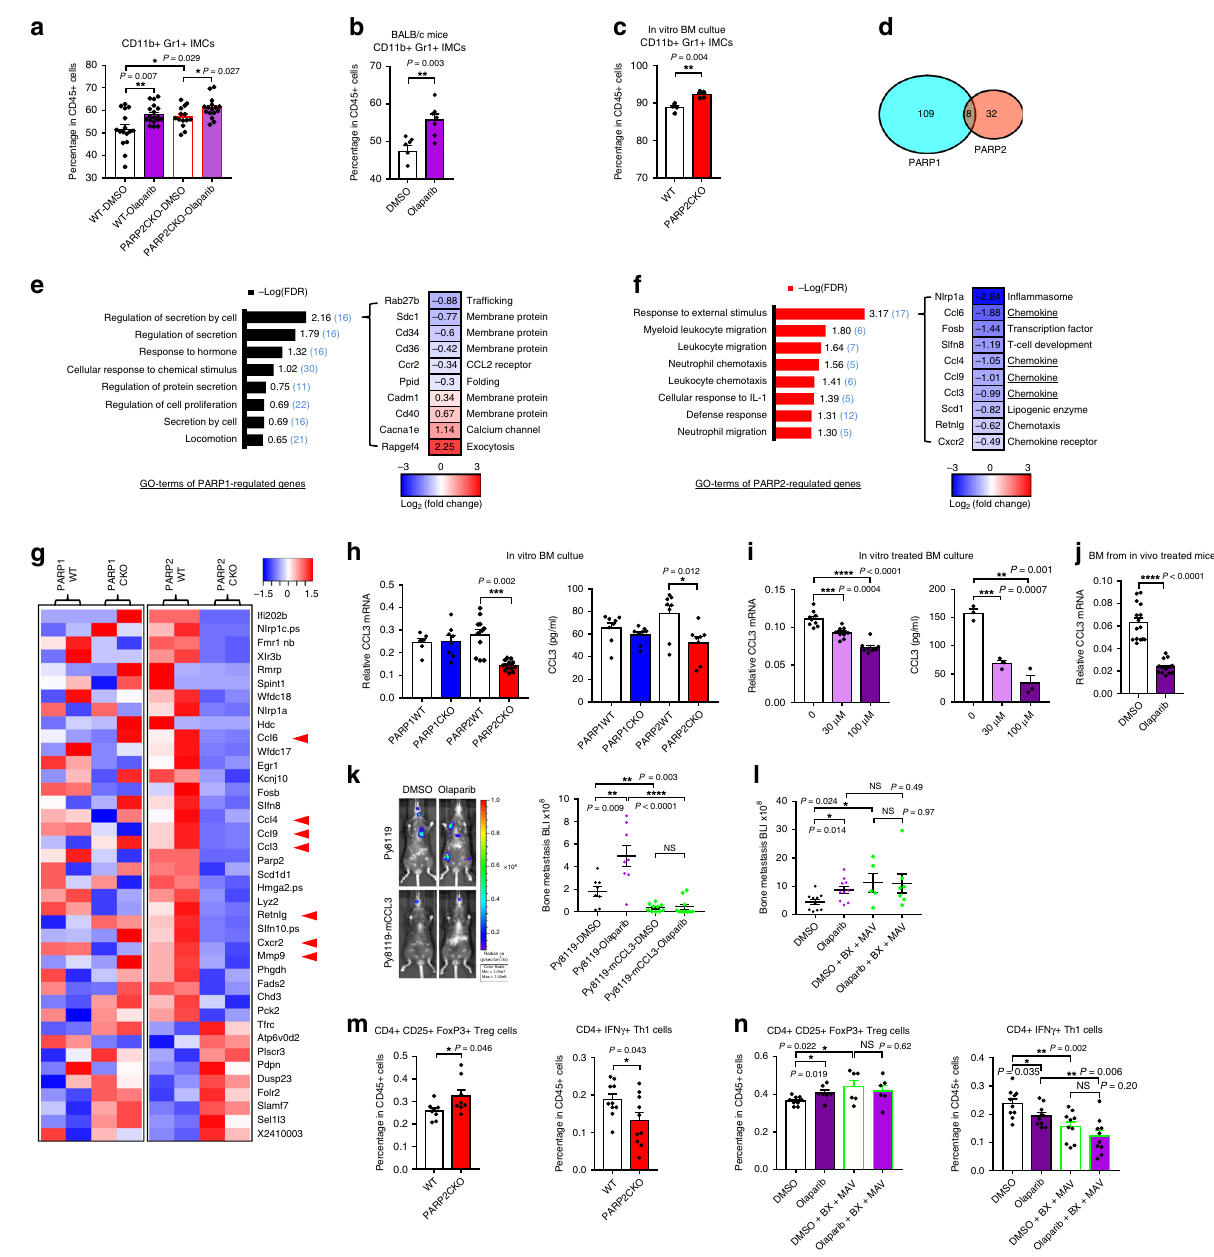
Fig. 3 PARP2 de fi ciency increases IMCs and decreases CCL3 expression. a Immature myeloid cells (IMCs) were increased by both olaparib and PARP2CKO shown by FACS analyses of bone marrow cells from mice intracardiacally injected with Py8119 cells ( n = 16). b Olaparib increased IMCs in bone marrow of BALB/c mice intracardiacally injected with 4T1.2 cells ( n = 7). c PARP2CKO increased IMCs of bone marrow cultures after 3 days of M- CSF treatment ( n = 4). d – g RNA-seq analyses of differential gene expressions in IMCs of PARP1CKO or PARP2CKO ( n = 2). d Diagram representation of overlap between PARP1 and PARP2 regulated genes. e , f Gene ontology terms enriched for PARP1 e or PARP2 f regulated genes and their top regulated genes. g Heat maps of expression levels for PARP2 regulated genes. Arrows, genes related to leukocyte migration. h RT-qPCR and ELISA analyses showed that CCL3 was reduced only in PARP2CKO IMCs ( n = 8). i CCL3 mRNA (left) or protein (right) in IMCs was suppressed by the treatment of 30 μ M or 100 μ M olaparib for 1 day ( n = 3). j CCL3 mRNA was reduced in the bone marrow cells of olaparib-treated B6 mice (2-month-old female, 5-week daily treatment, n = 15). k Bone metastasis of Py8119-mCCL3 cells in mice treated with DMSO or olaparib ( n = 10) was lower than Py8119 cells ( n = 8). l Bone metastasis of Py8119 cells in mice treated with CCR1 antagonist, BX-471 (BX), plus CCR5 antagonist, Maraviroc (MAV; n = 7) was exacerbated compared with DMSO group ( n = 10). m PARP2CKO increased regulatory T cells (Treg; n = 8) and reduced type 1 T helper cells (Th1; n = 10) in bone marrow of mice intracardiacally injected with Py8119 cells. n Both olaparib and CCR1/5 antagonists increased Treg ( n = 6) and reduced Th1 cells ( n = 10) in bone marrow from mice in l . Data represent mean ± SEM, * P < 0.05, ** P < 0.01, *** P < 0.001, **** P < 0.0001; NS nonsigni fi cant. Two-sided Student ’ s t -test was used to calculate statistical difference. Source data are provided as a Source Data fi